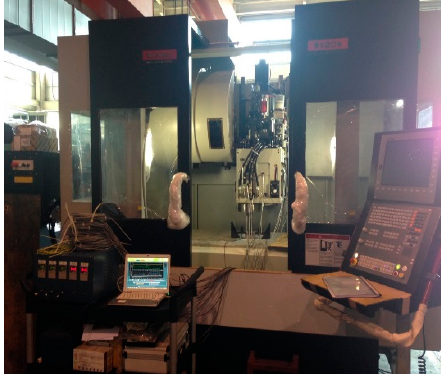
Figure 3. MV204C Quaser machine tools.